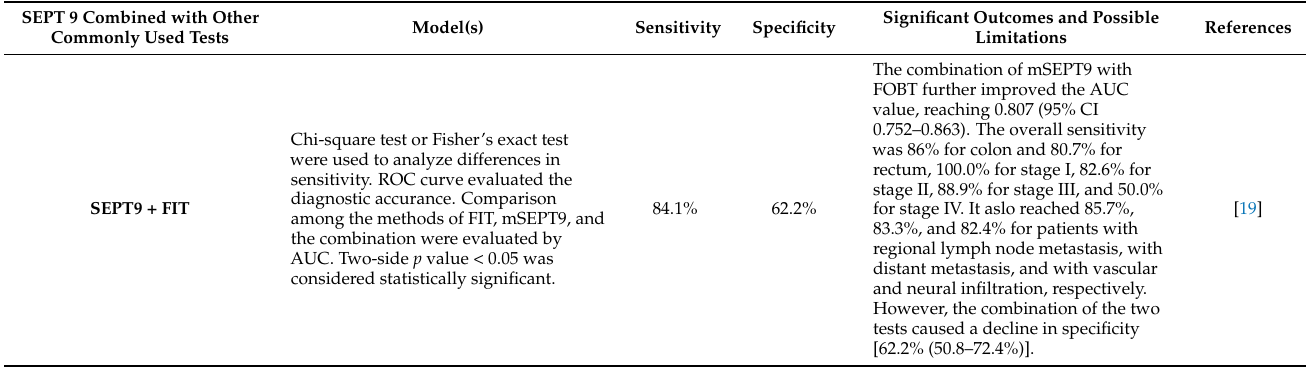
Table 2. Efficacy of SEPT9 in combination with FIT or CEA for CRC